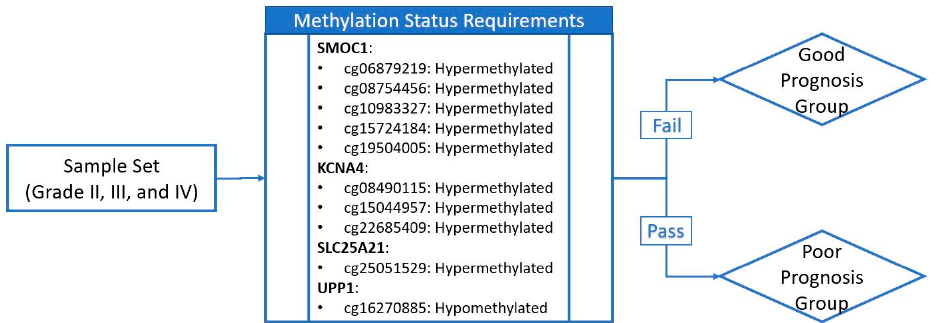
Figure 2. Schematic diagram of sample grouping criteria. If the sample meets methylation status requirements for all ten CpG sites (represented by probe IDs from the array product design), it is assigned to the poor prognosis group. If the sample fails one or more of the methylation status requirements, it is assigned to the good prognosis group. Hypo- or hypermethylation status of the sample is determined through comparison with the group median methylation level. In the main text, there was an error in Paragraph 1, 3rd sentence of Section 2.1. The 35 definition of hypo- and hypermethylated CpG sites outputted from the differential 36 variability analysis is an inexact description. A correction has been made to this as 37 presented below: 38